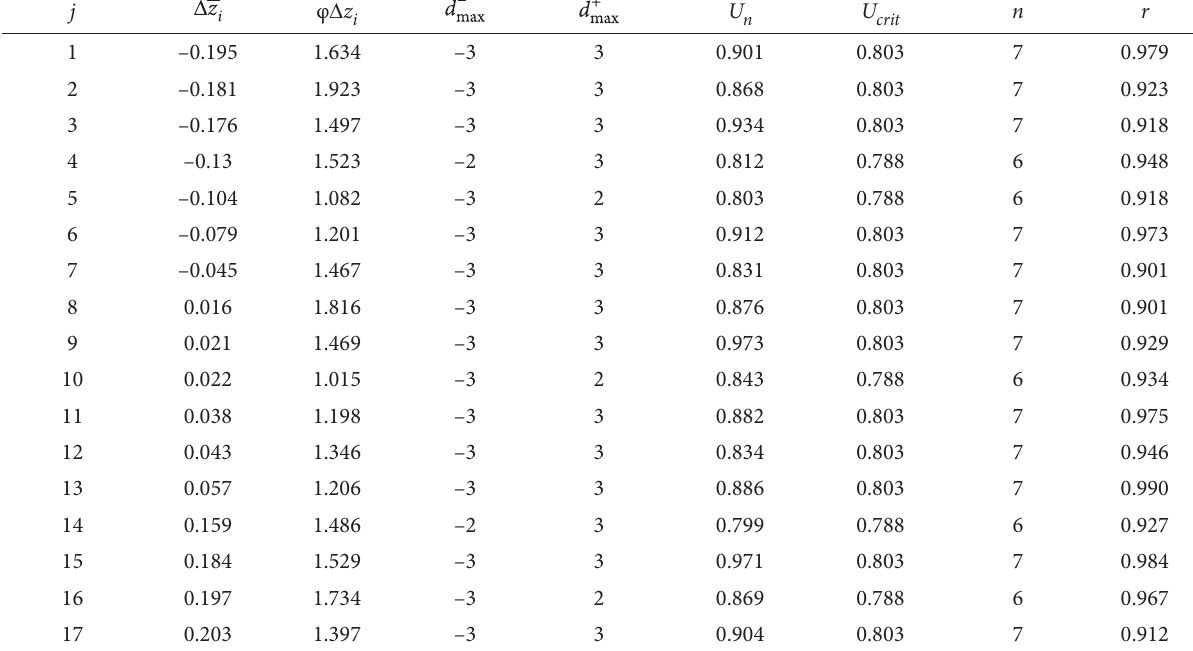
Table 2. The results of analysis of the seventeen selected measurement cross sections in the coplanar type of measurements j φ ∆ z i U n U